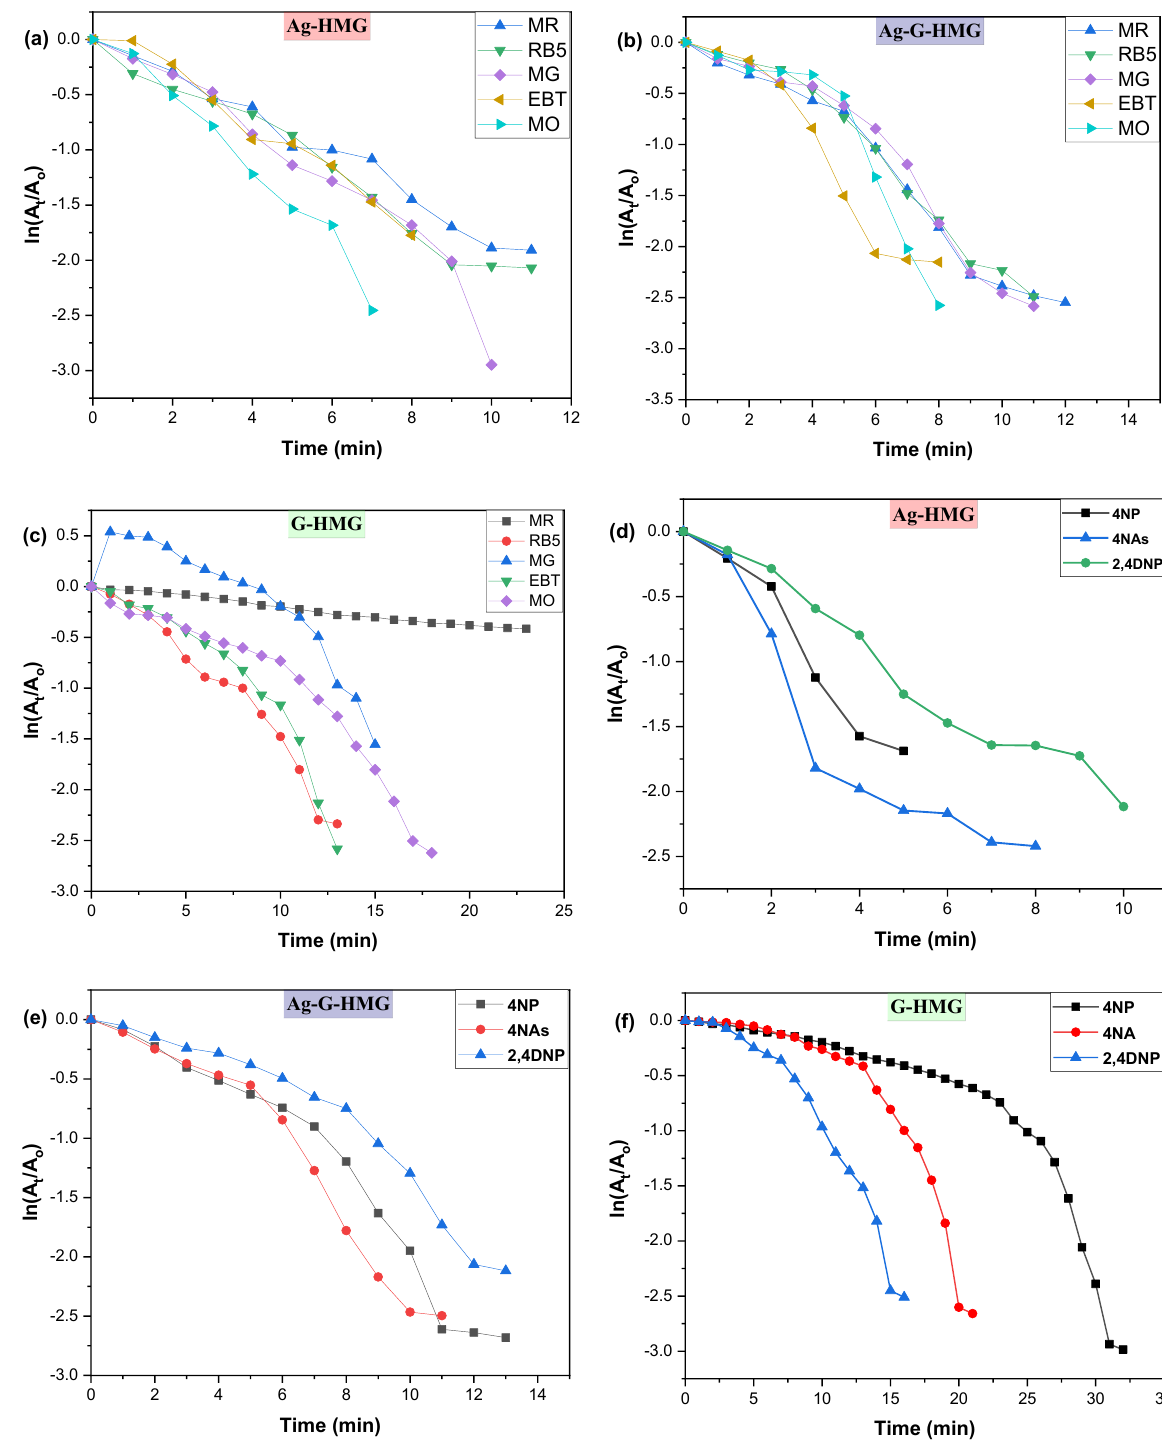
Figure 2. A plot of ln(A t /A o ) versus time of catalytic reduction of MR, RB-5, MG, EBT, MO using ( a ) Ag-HMG, ( b ) Ag-G-HMG, and ( c ) G-HMG as catalysts and a plot of ln(A t /A o ) versus time of catalytic the reduction of 4-NP, 4-NAs, and 2,4 DNP using ( d ) Ag-HMG, ( e ) Ag-G-HMG, and ( f ) G-HMG as catalysts.